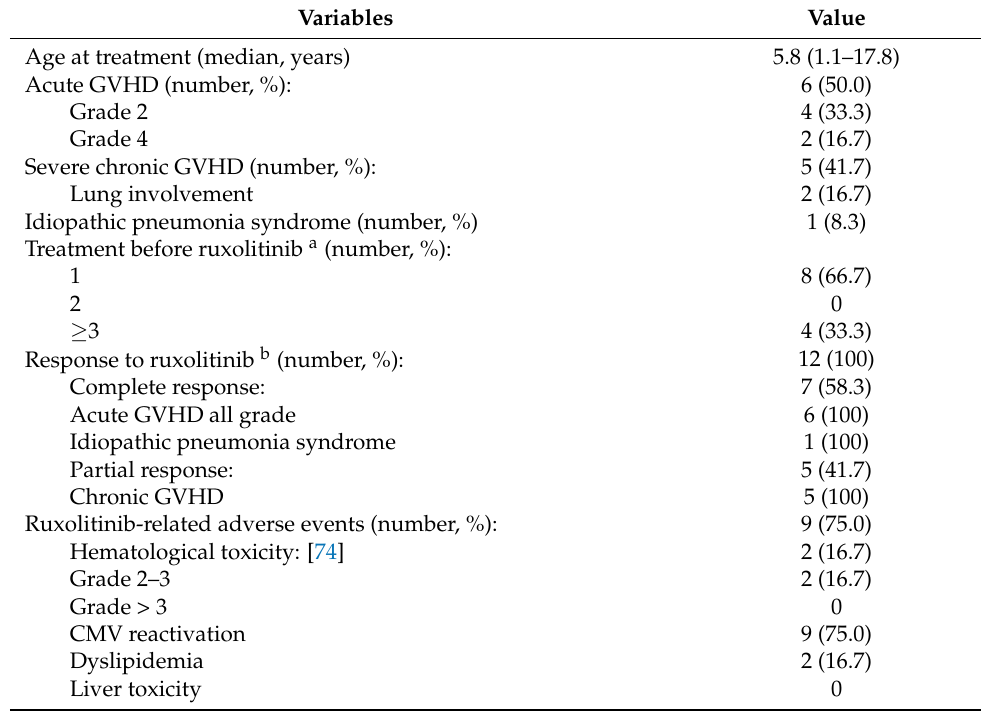
Table 1. Patients and GVHD characteristics and ruxolitinib outcomes. Variables